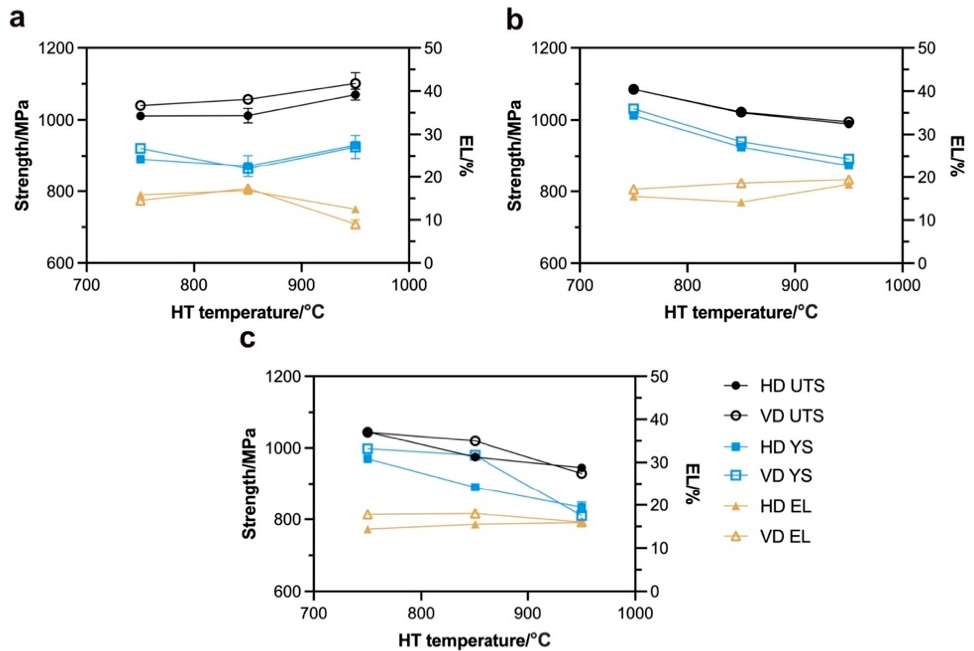
Figure 2. Tensile performances of SLMed Ti-64 after different heat treatment methods: ( a ) WQ sam- ples, ( b ) AC samples, ( c ) FC samples. UTS: ultimate tensile strength, YS; yield strength, EL: elonga- tion.